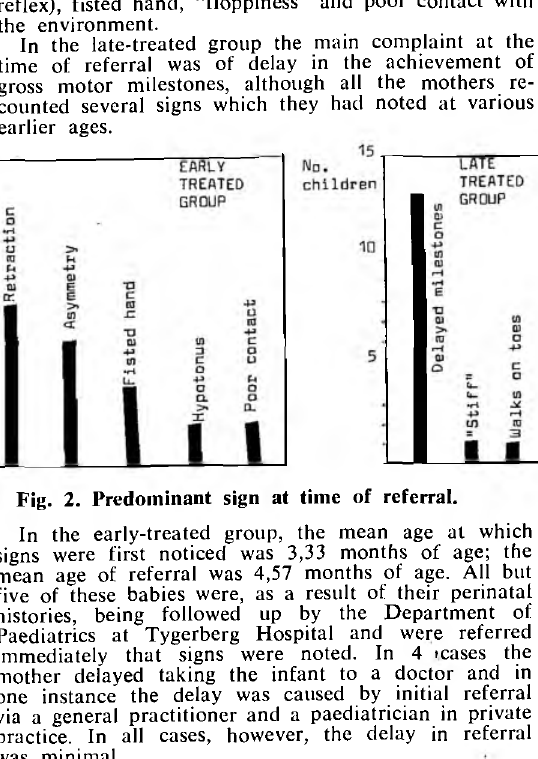
Hypo- Athe- tanic